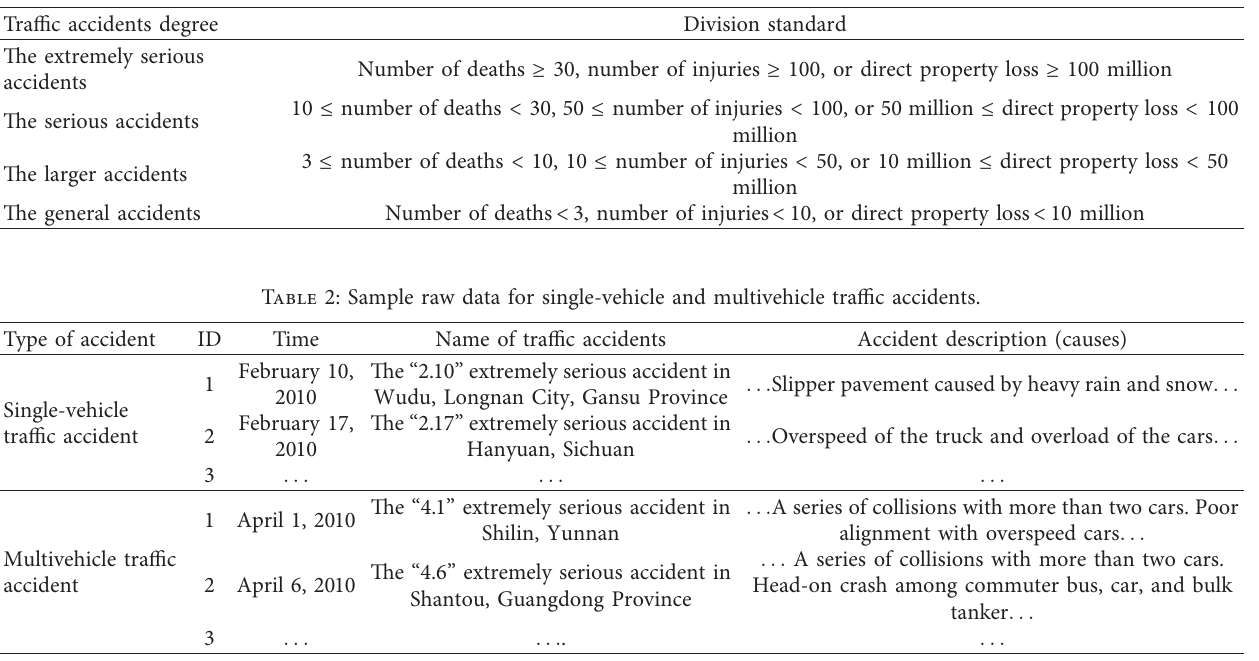
Table 1: Accident classification standard.